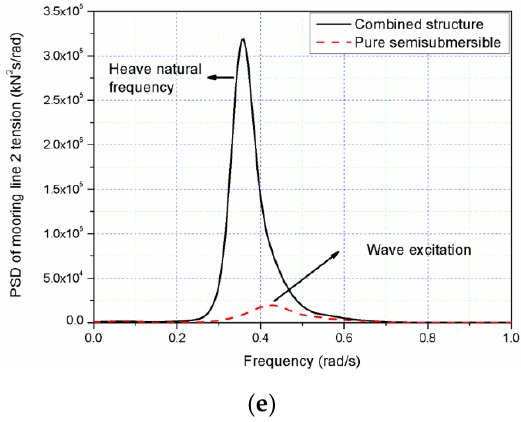
Figure 21. PSD of motion responses for the extreme sea state LC4: ( a ) surge; ( b ) heave; ( c ) pitch; ( d ) mooring line 1 tension; ( e ) mooring line 2 tension.